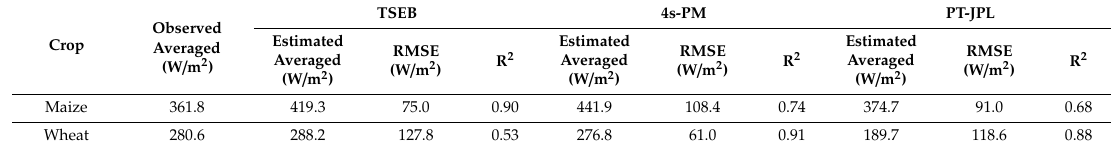
Table 2. Statistics of the three models derived Latent heat flux for maize and wheat.